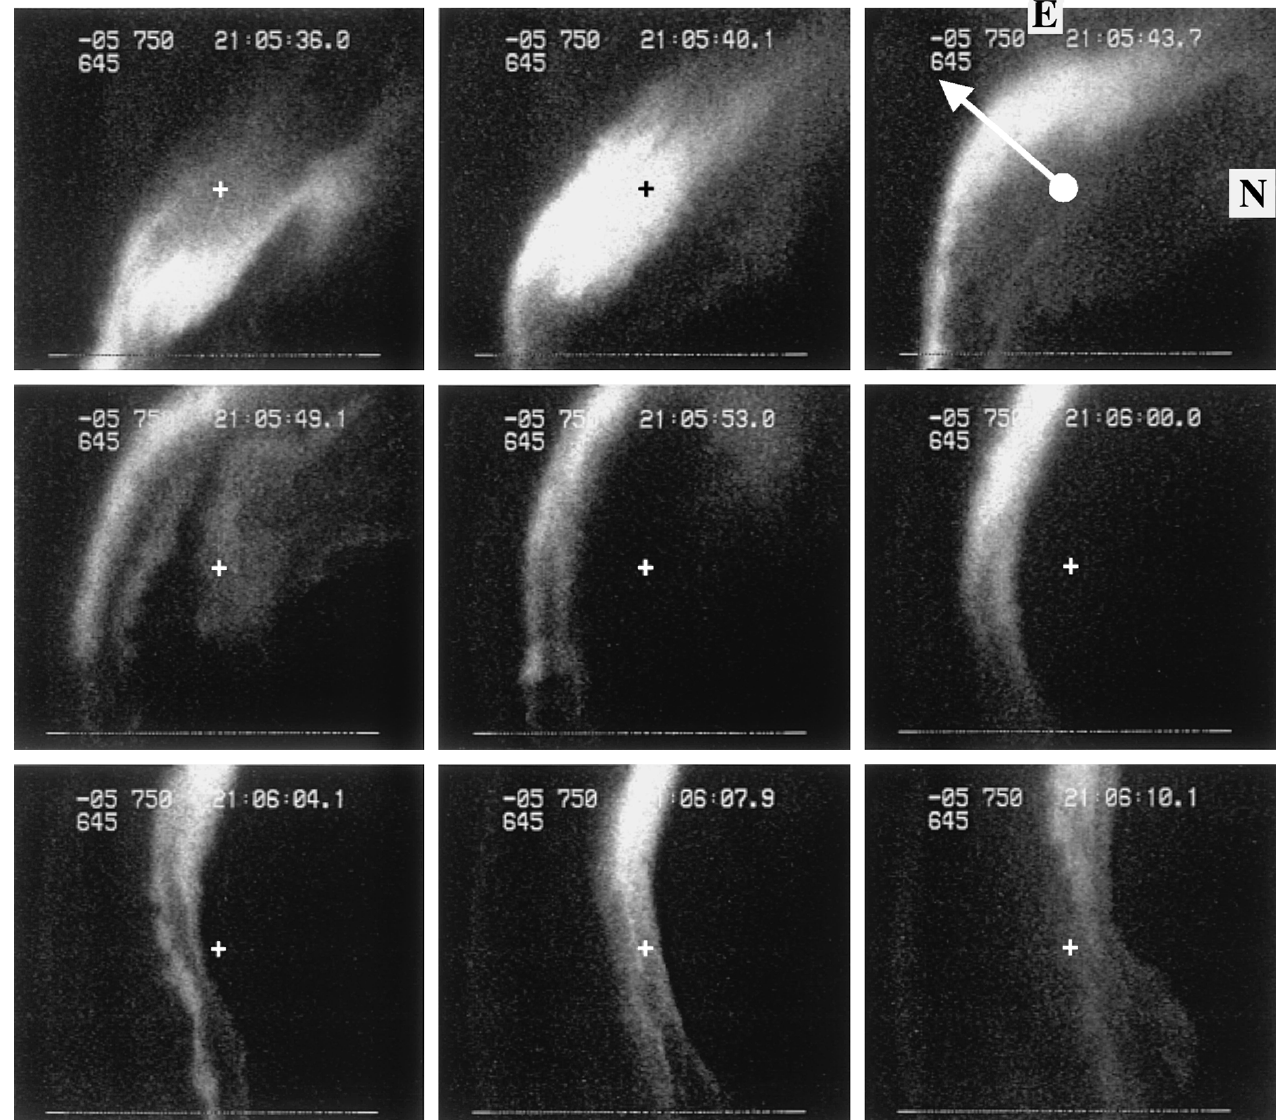
Fig. 2. Sequence of images from wide-angle camera at 21:05:36.0, 40.1, 43.7, 49.1, 53.0, and 21:06:00.0, 04.1, 07.9, 10.1 UT. The position of the radar beam is marked with a cross . North is to the right and